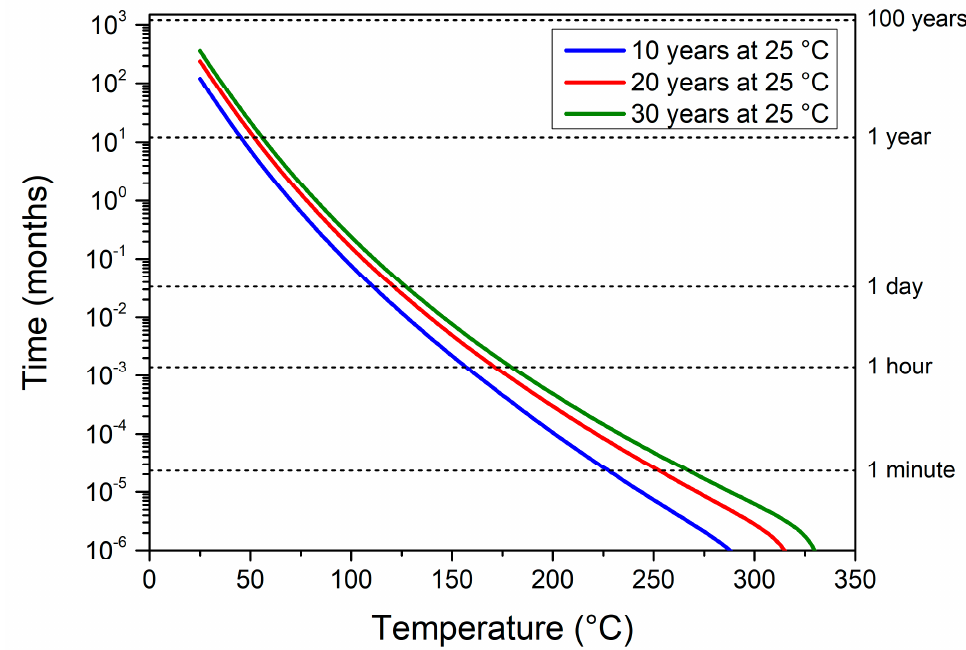
Figure 2. Time–temperature couples giving equivalence to 10, 20, and 30 years natural aging at the ambient temperature for a fuel rich ξ 2 Al/CuO 150/150.